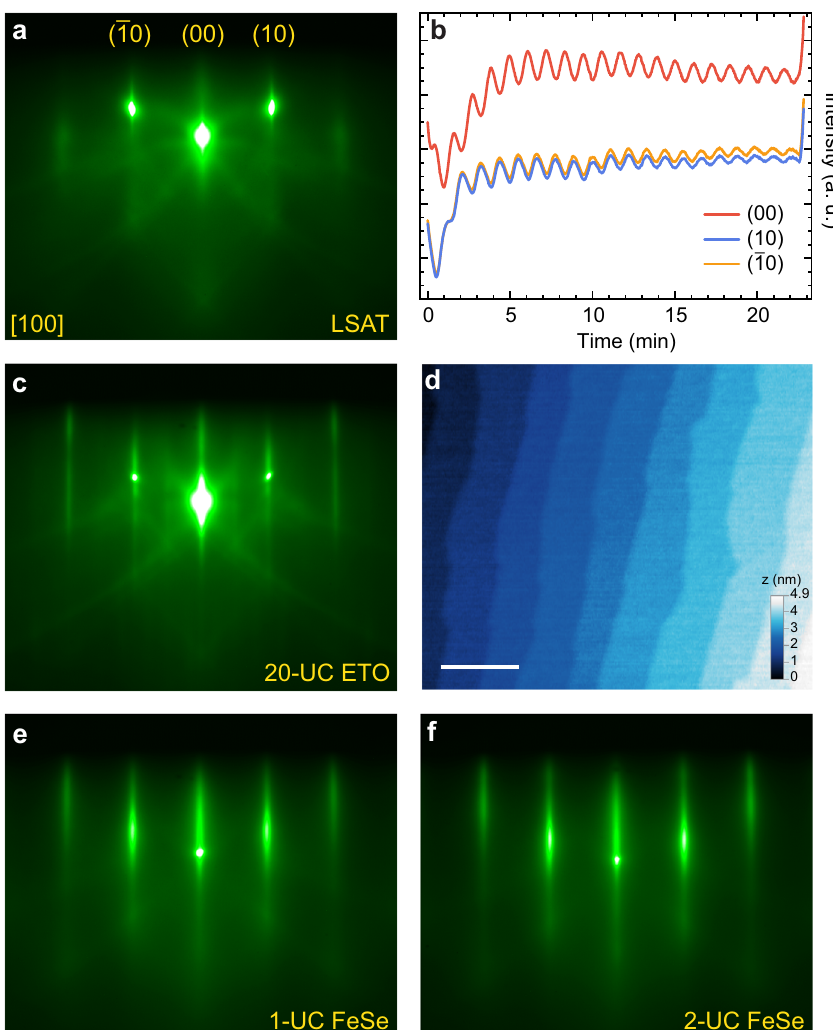
Fig. 1 MBE growth of the fi lms. a RHEED pattern of the LSAT substrate. b RHEED oscillations during the growth of the 20-UC ETO. c RHEED pattern of the 20-UC ETO on LSAT. d Atomic force microscope image of the 20-UC ETO. The length of the scale bar corresponds to 200 nm. e RHEED pattern of 1-UC FeSe on ETO. f RHEED pattern of 2-UC FeSe on ETO. The incident electron beam is along the [100] direction of the substrate for all RHEED Fig. 1e,f. The fi lm thickness can be simply controlled by the deposition time. The coincident diffraction-streak positions of all the layers indicate similar in-plane lattice constants and lattice heterostructure.